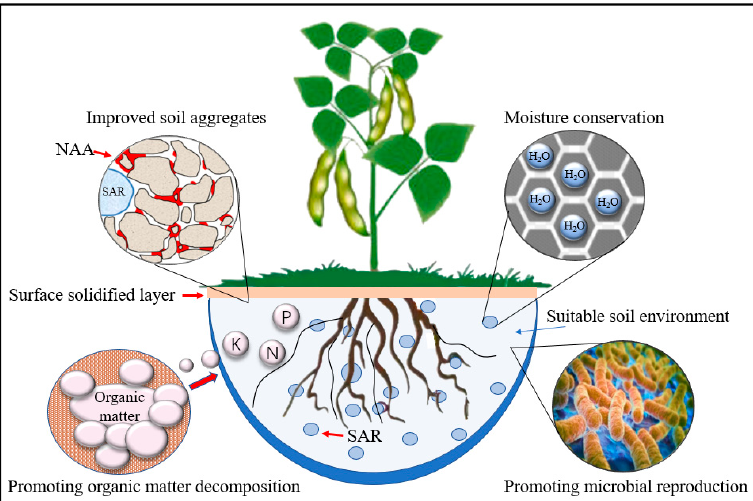
Figure 10. Schematic diagram of the mechanism of ADNB-improved soil.